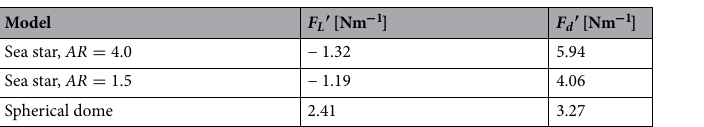
Model F L ′ [Nm − 1 ] F d ′ [Nm − 1 ] Sea star, AR = 4.0 − 1.32 5.94 Sea star, AR = 1.5 −